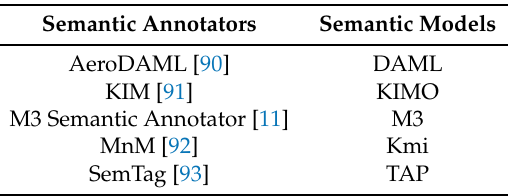
Table 3. The Mappings between Semantic Annotators and Semantic Models.